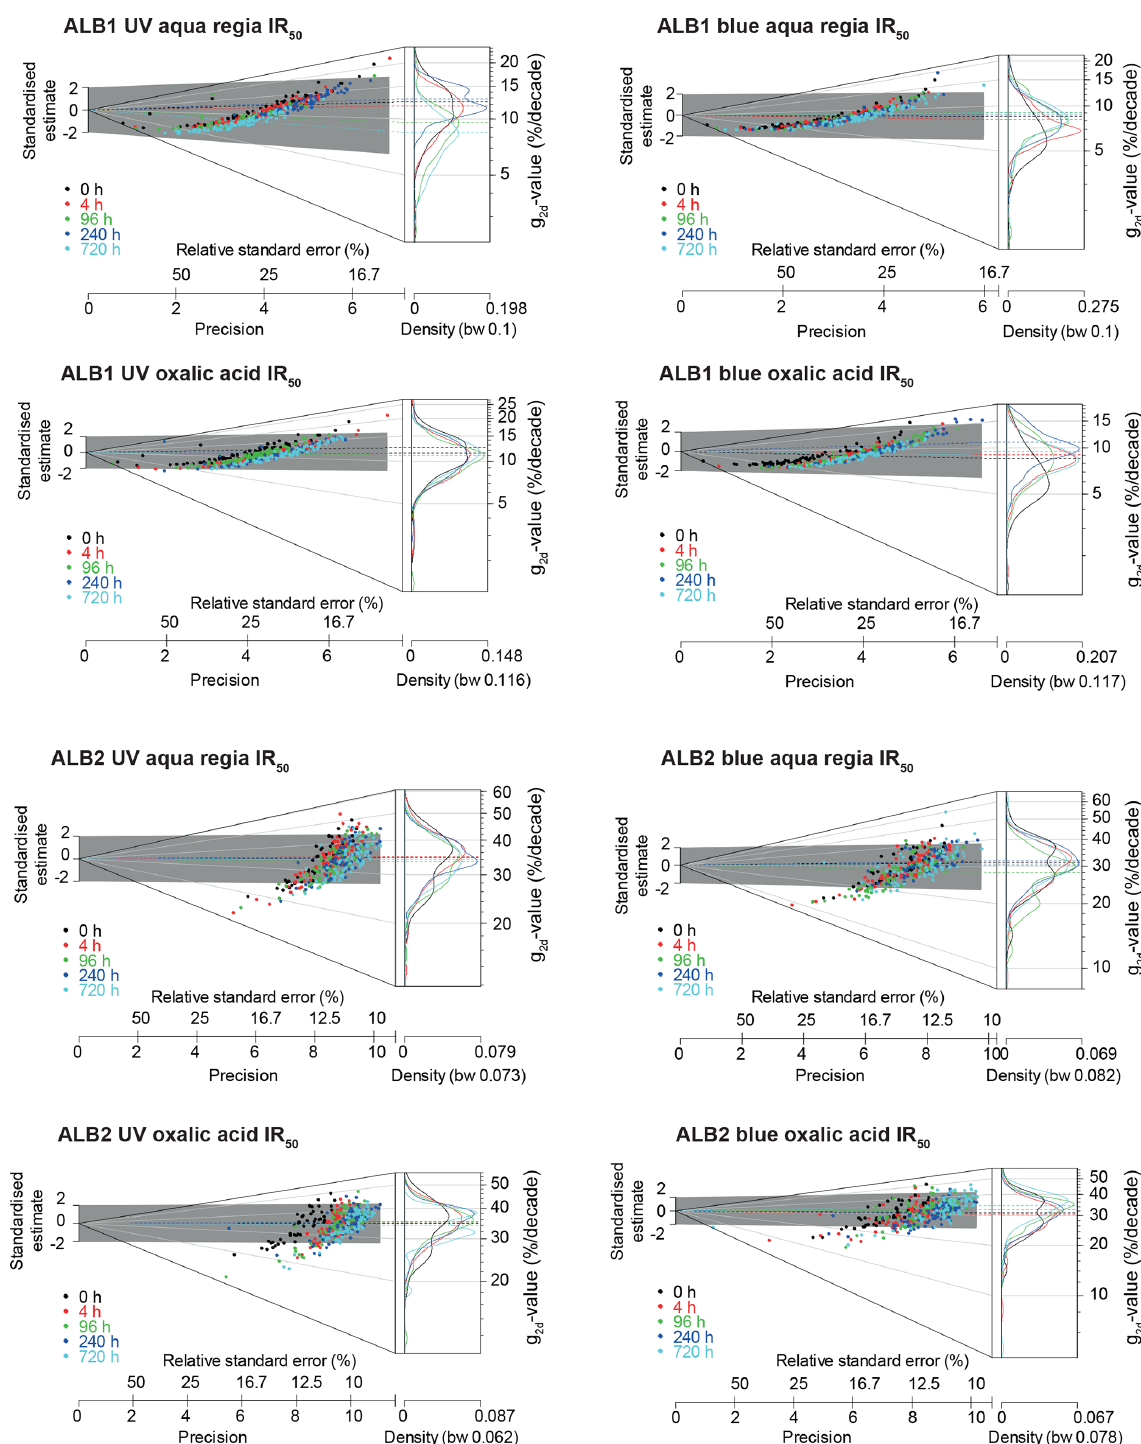
Figure 8. Single-grain fading data of the IR 50 signals illustrated as abanico plots (Dietze et al., 2016). Fading rates are normalised to 2d ( g 2d ; Huntley and Lamothe, 2001) as a function of treatment time from 0h (untreated) to 720h for the near-UV and blue wavelength regions and two acid solutions (aqua regia and oxalic acid). The mean is centred in the abanico